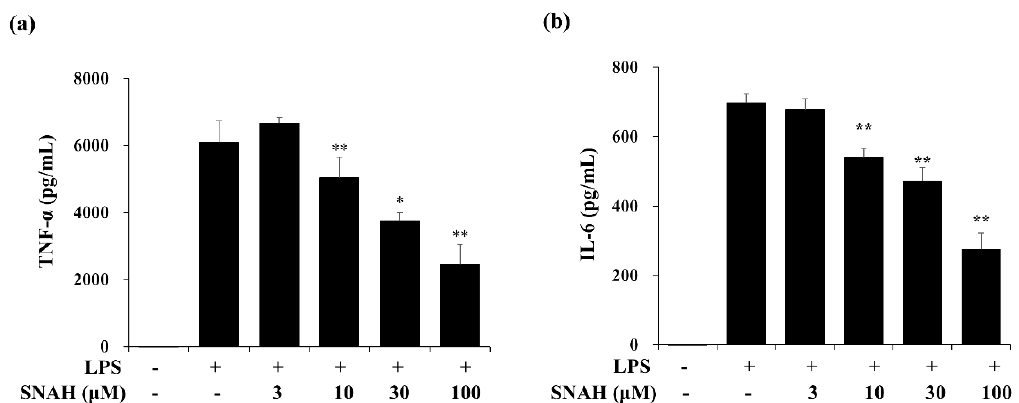
Figure 2. E ff ects of SNAH on LPS-induced TNF- α ( a ) and IL-6 ( b ) production. RAW 264.7 cells were pretreated with 3, 10, 30, and 100 µ M SNAH for 1 h before treatment with 1 µ g / mL LPS. After incubation for 18 h, IL-6 and TNF- α production was detected by ELISA. The values are presented as means ± SD of three independent experiments. * p < 0.05, ** p < 0.01 compared to the LPS-treated